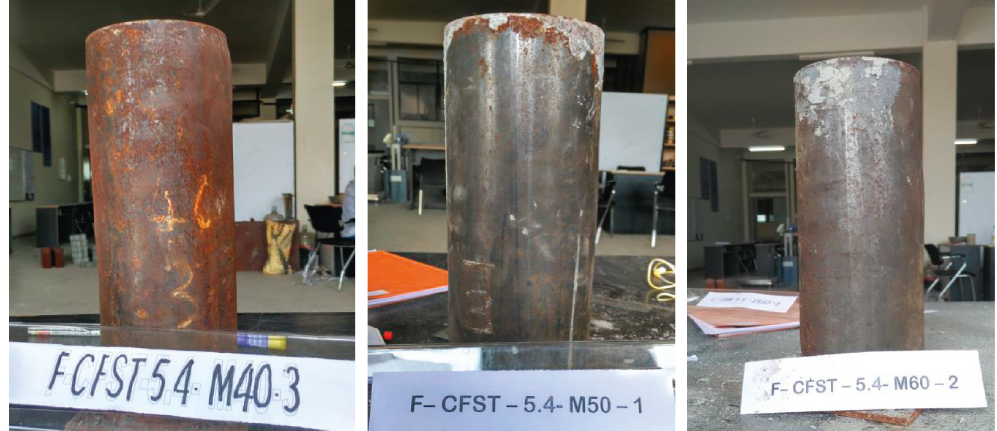
Figure 2: Failure shape of CFST-21.22-40, CFST-21.22-50 and CFST-21.22-60.